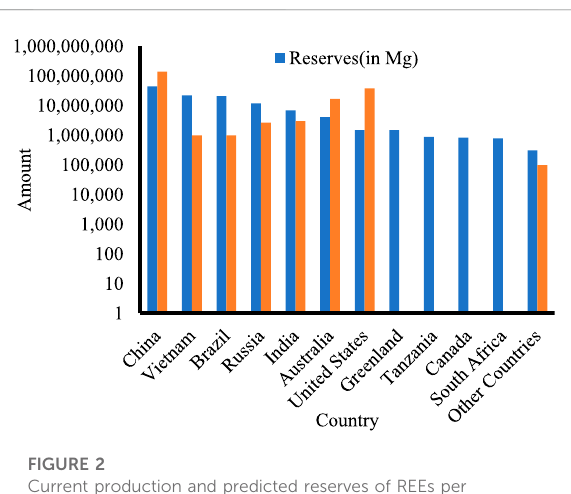
Current production and predicted reserves of REEs per country plotted based on the data by (LePan,